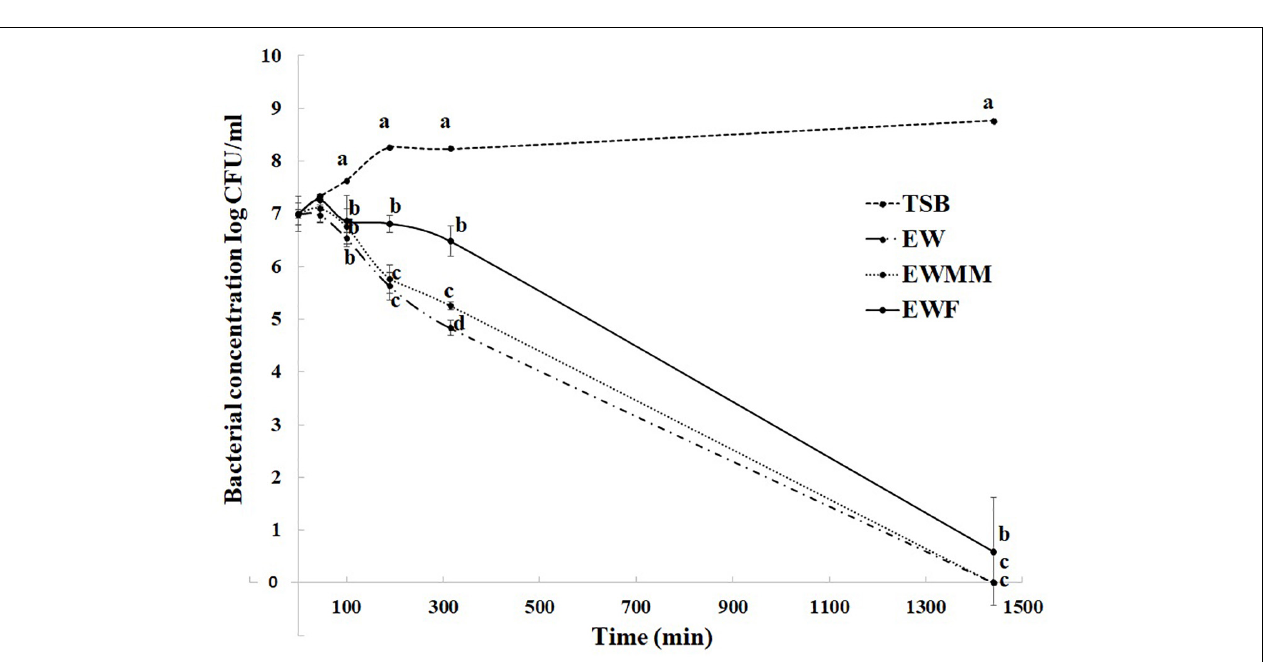
FIGURE 1 | S. Enteritidis survival after 24 h at 30 or 45 ◦ C in TSB (control), EW, EWF (free of EW proteins of > 10 kDa) and EWMM (EWF with 10% EW). Inoculum levels were 6.9 ± 0.2 log 10 CFU/mL. Means of triplicate experiments are shown with standard deviations. For each condition, results were compared using analysis of variance and the average comparison test using R software. Letters identify averages that are significantly different ( p ≤ 0.05).